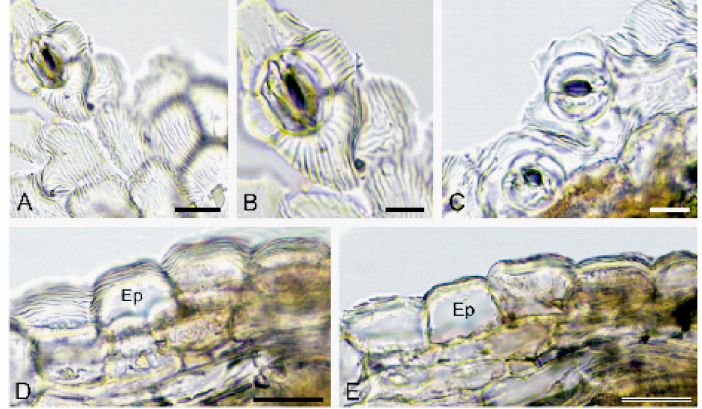
Figure 10. Characteristics of the abaxial epidermis of bracts in Artemisia artemisiifolia male capitula: ( A , B ) Stomatal complexes composed of two guard cells, four subsidiary cells, and epidermis cells with striated cuticle; ( C ) Dense arrangement of stomata; ( D , E ) Cross-section of epidermis cells (Ep); ( D ) Outer cell walls covered by cuticle with distinct striation; ( E ) Thick outer wall in epidermis cells; Scale bars: A , D , E —10 µ m, B , C —20 µ